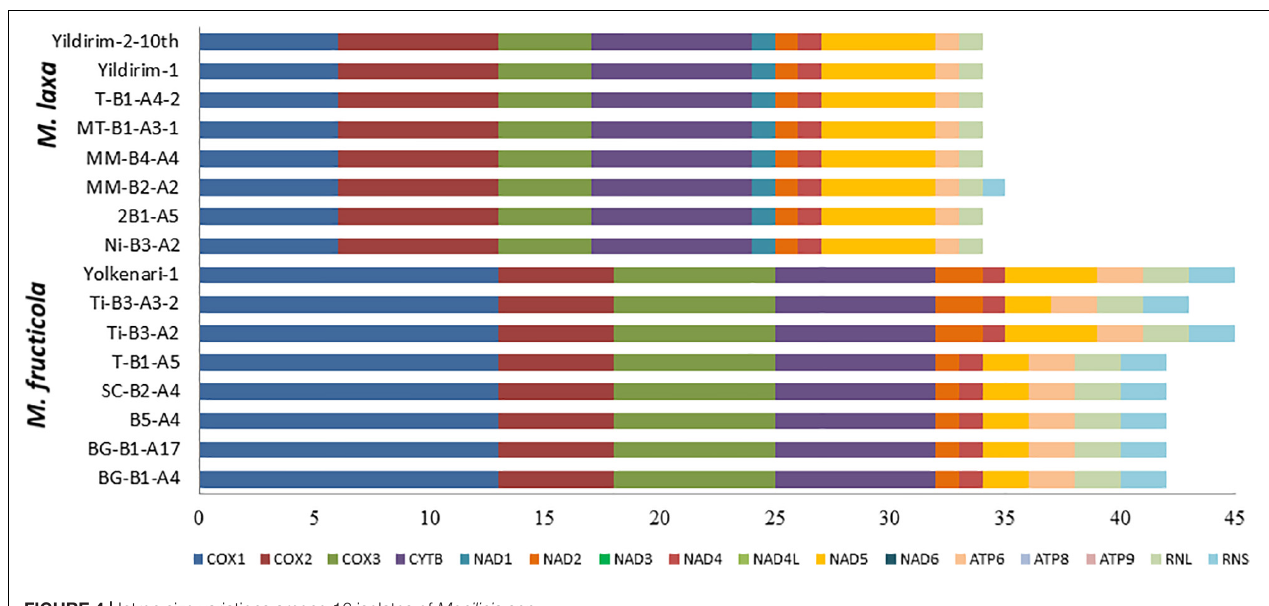
FIGURE 4 | Intron size variations among 16 isolates of Monilinia spp.